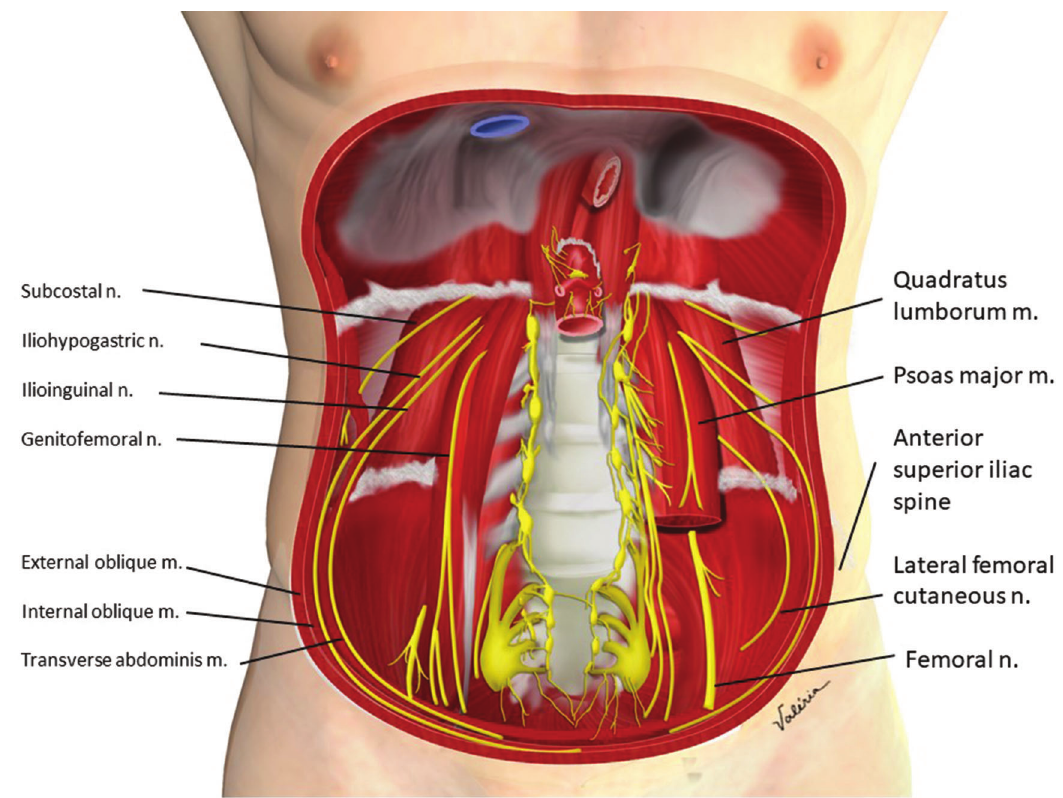
Figure 11 - Arrangement and path of the II and IH nerves in the abdominal wall.